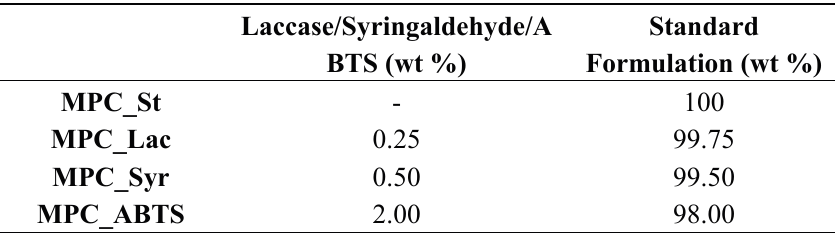
Table 5. Composition of the cryogel mixtures (in PBS